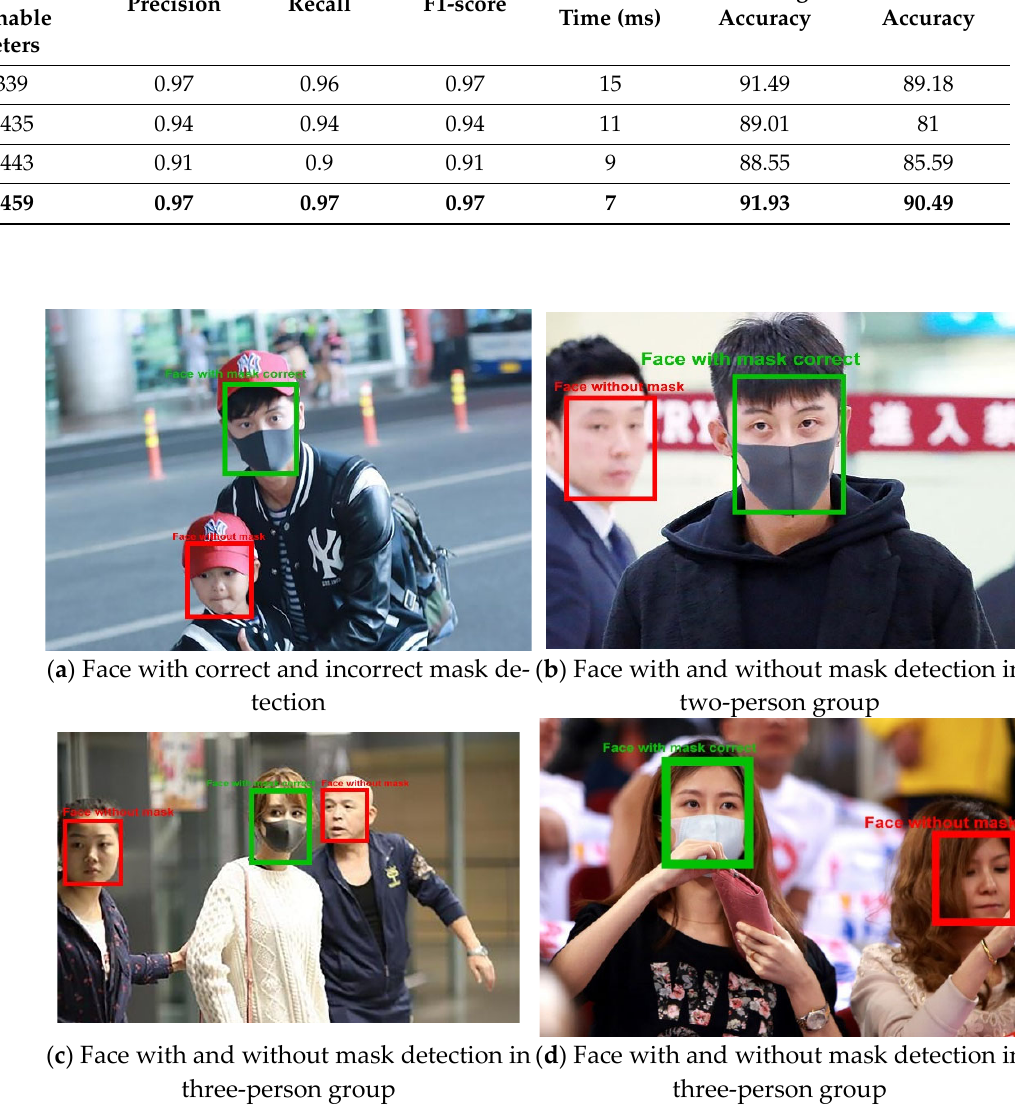
Figure 9. Screenshots of three ‐ class face mask detection.